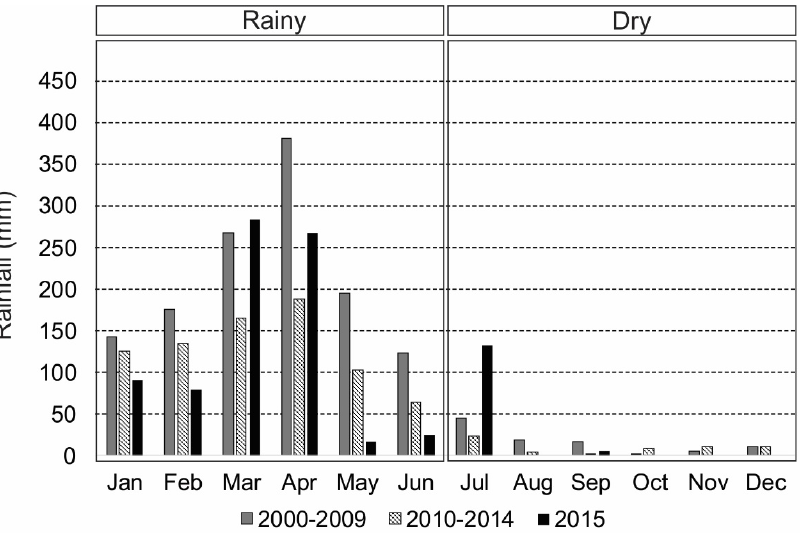
Figure 3. Mean precipitation (mm) of annual rainfall data (2000–2009), last drought cycle (2010– 2014) [23] and collection date (2015) in Piranji Estuary (equatorial Southwestern Atlantic, Brazil)